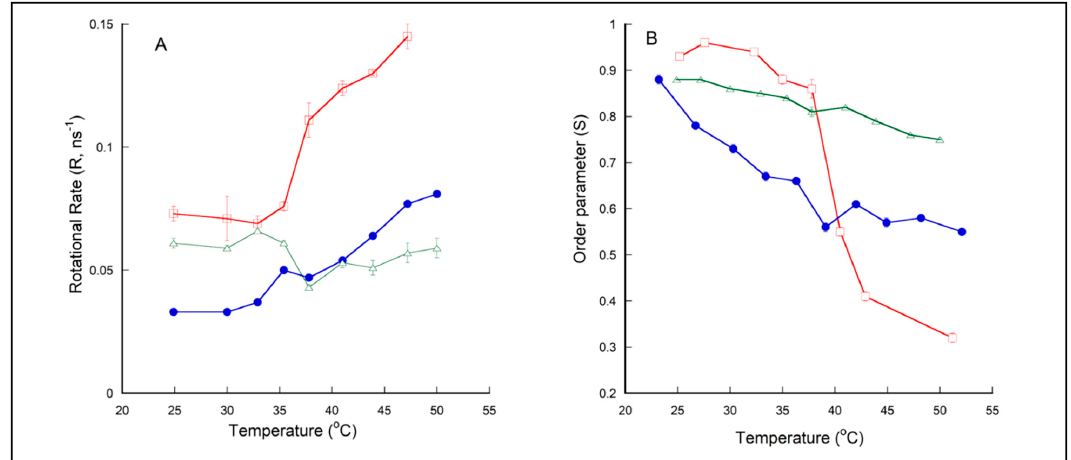
Figure 3. Temperature dependence of ( A ) the rotational rate constant, R, and ( B ) order parameter, S, experienced by 1,6-diphenyl-1,3,5-hexatriene (DPH) in liposomal membranes made of DPPC (red squares), PLFE (green triangles), or PLFE/DPPC(3:7) archaeosomes (blue circles). Particle size range: 154–160 nm. Error bars are the standard deviations from three separated measurements. Comparing the S value at 39.1 ° C with that at 36.3 ° C or 42.0 ° C for PLFE/DPPC(3:7) archaeosomes, gives a p value < 0.01.